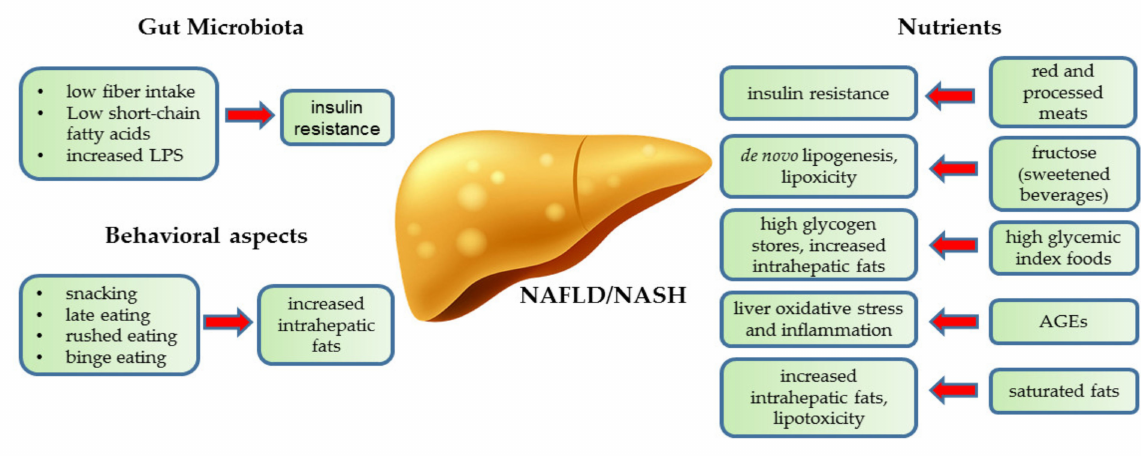
Figure 1. Impact of gut microbiota, behavioral aspects and specific nutrients on features of liver damage leading to Non Alcoholic Fatty Liver Disease/Non Alcoholic Steatohepatitis (NAFLD/NASH). Abbreviations: AGEs, advanced glycation end-products; LPS,